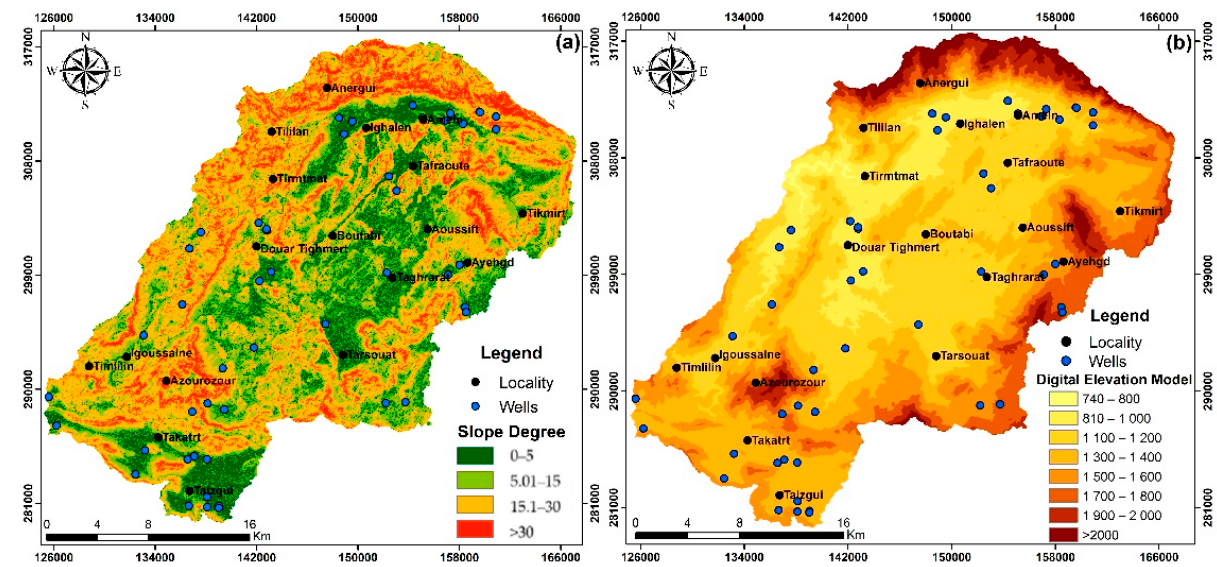
Figure 7. Topographical factors influencing groundwater. ( a ) Slope degree; ( b ) Altitude.